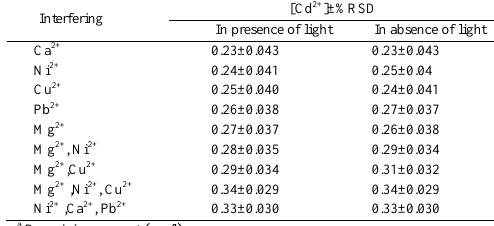
Table 5. Removal %RSD lead (II) and cadmium (II) ion by Nd-TiO 2 / bentonite and Ce-